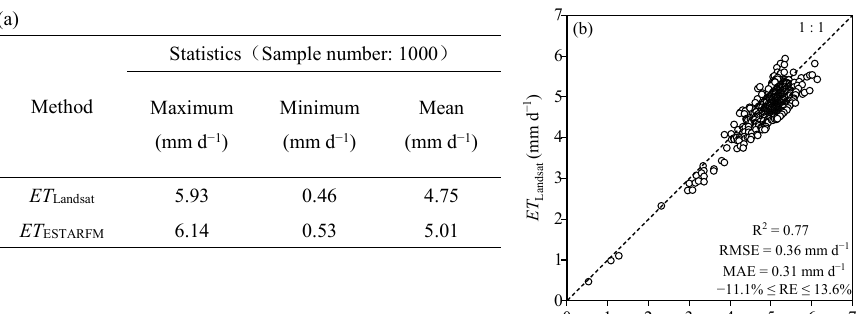
Figure 4. Comparisons of fused ET ESTARFM and estimated ET Landsat in cotton fields under film-mulched drip irrigation in the Manas River Basin on 1 August 2018: ( a ) Table for the statistical characteristics of fused ET ESTARFM and estimated ET Landsat ; and ( b ) 1:1 diagram (R 2 : coefficient of determination; RMSE: root-mean-square error; RE: relative error; MAE: mean absolute